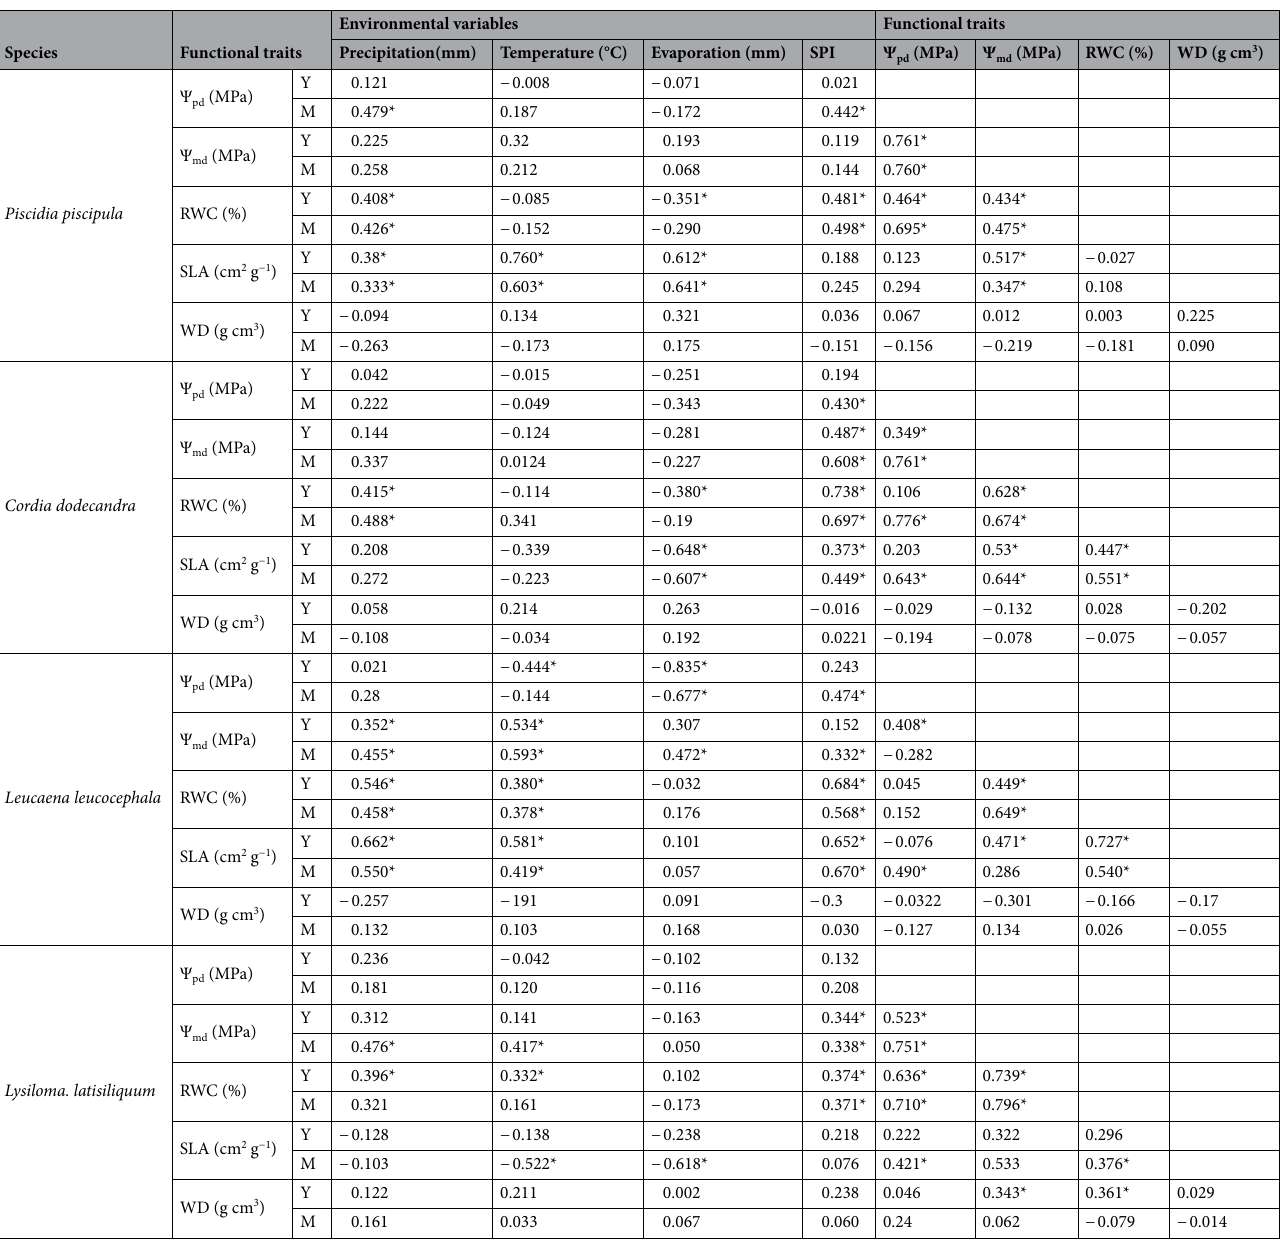
Table 3. Correlation between environmental variables and functional traits of deciduous species. SPI: standardized precipitation index (the value corresponds to the month of October). Pearson correlation, the values marked with asterisks are significant (P <